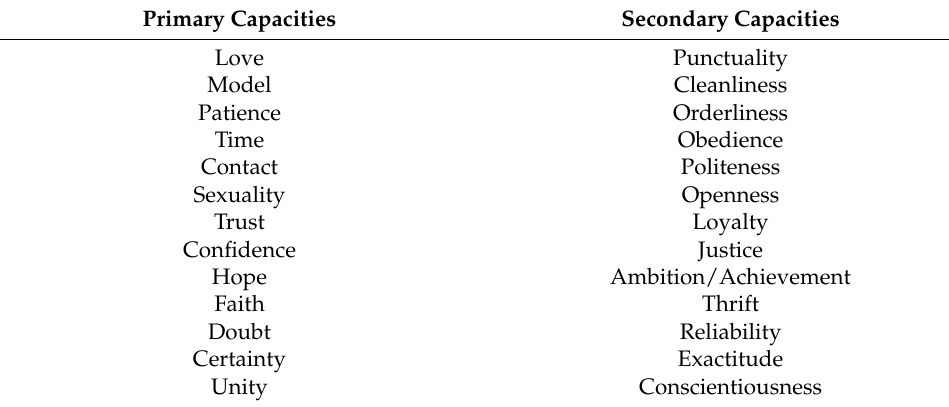
Table 1. Primary and secondary capacities based on [11],